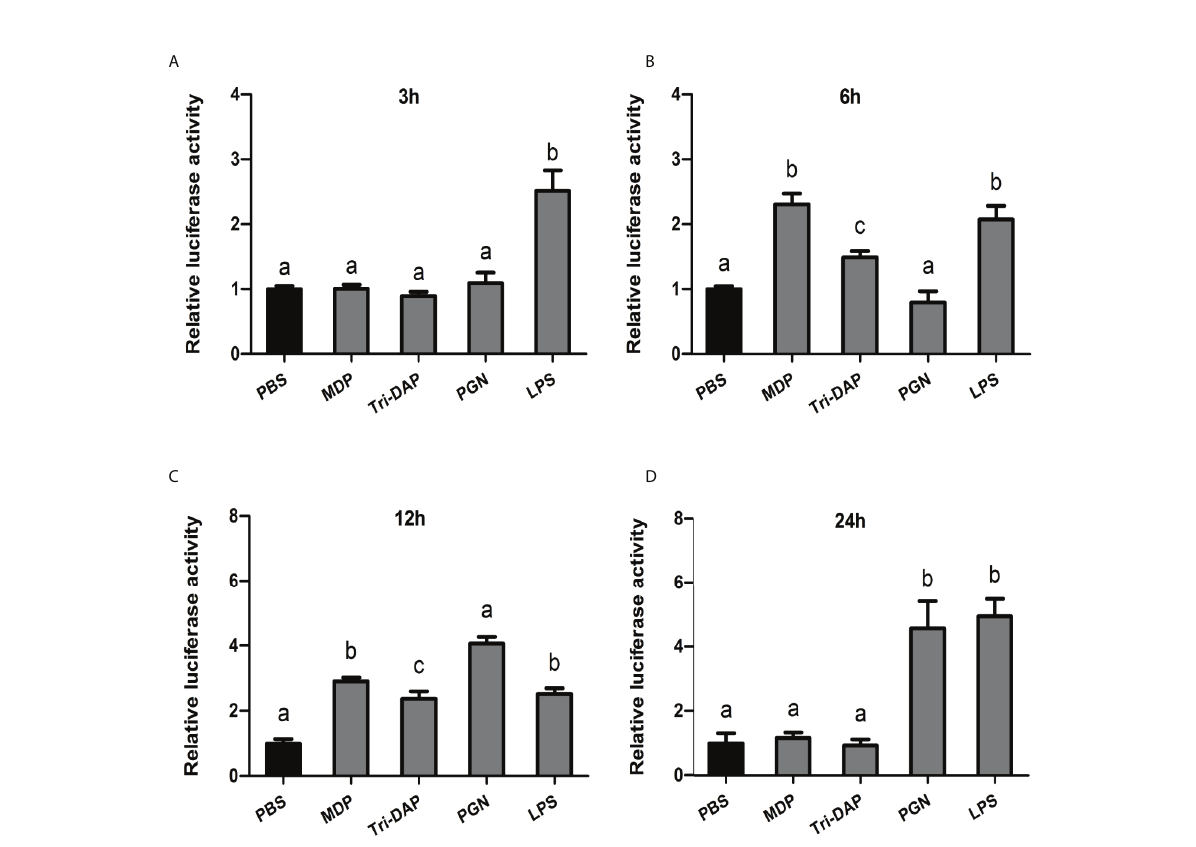
FIGURE 8 Temporal expression pro fi les of Ci MEKK3 mRNA in intestinal cells at 3 h (A) , 6 h (B) , 12 h (C) and 24 h (D) post-challenge with MDP, Tri-DAP, PGN or LPS. Data are shown as the mean ± standard error of three individual fi sh ( N = 3). Signi fi cant differences between the challenge group and the control group are indicated with different letters ( P <